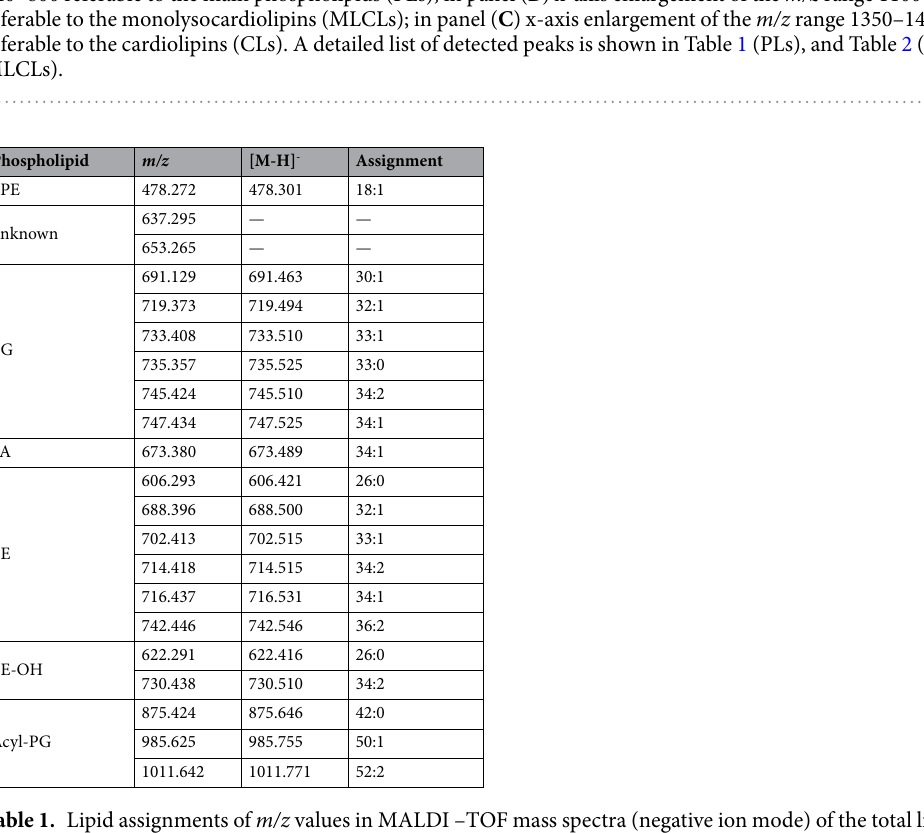
Table 1. Lipid assignments of m/z values in MALDI –TOF mass spectra (negative ion mode) of the total lipid extract of Acinetobacter baumannii . The numbers (x:y) denote the total length (as carbon numbers) and number of double bonds of both acyl chains